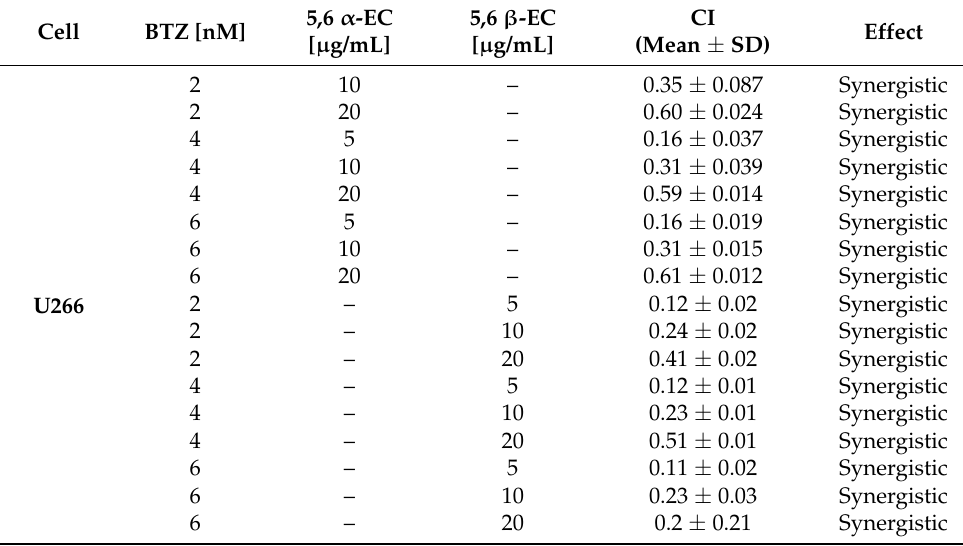
Table 3. Synergistic effect of 5,6-ECs associated with